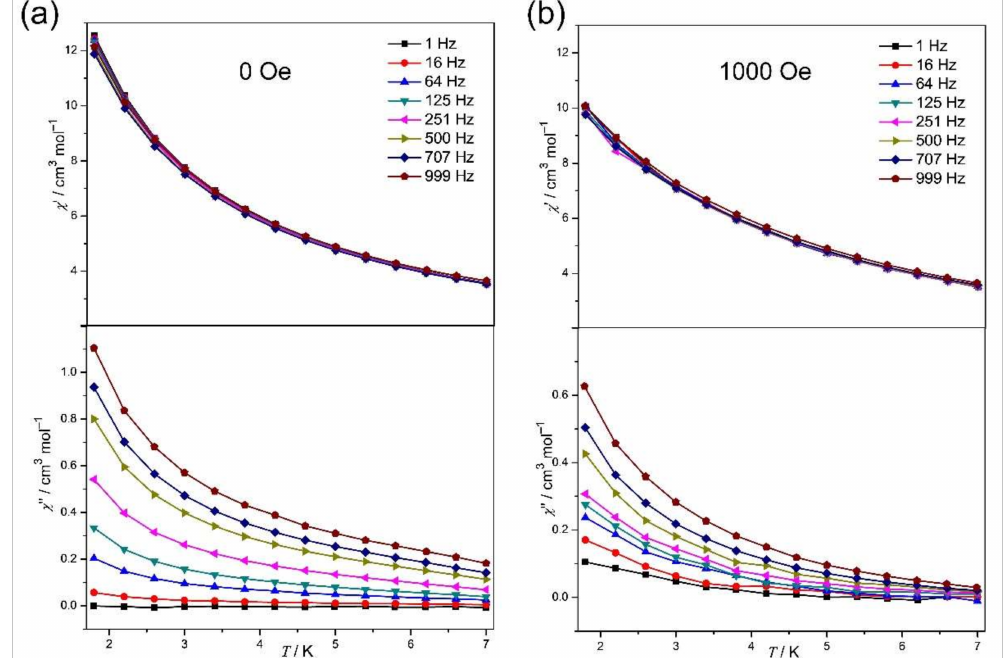
Figure 6. ( a ) Temperature-dependent in-phase χ (cid:48) and out-of-phase χ (cid:48)(cid:48) ac susceptibility signals for Dy- m -TTFTB at the indicated frequencies under zero dc field. ( b ) Temperature-dependent in-phase χ (cid:48) and out-of-phase χ (cid:48)(cid:48) ac susceptibility signals for Dy- m -TTFTB at the indicated frequencies under 1000